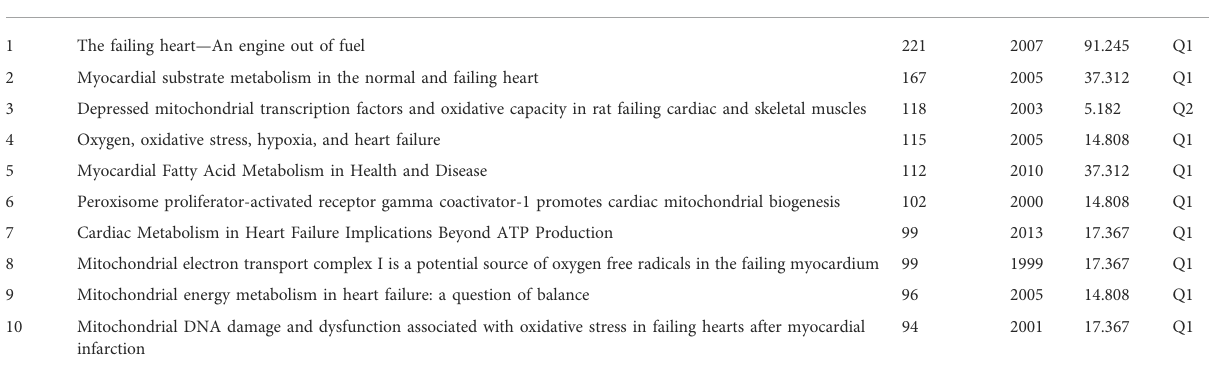
TABLE 5 Top 10 co-cited references related to mitochondrial function and heart